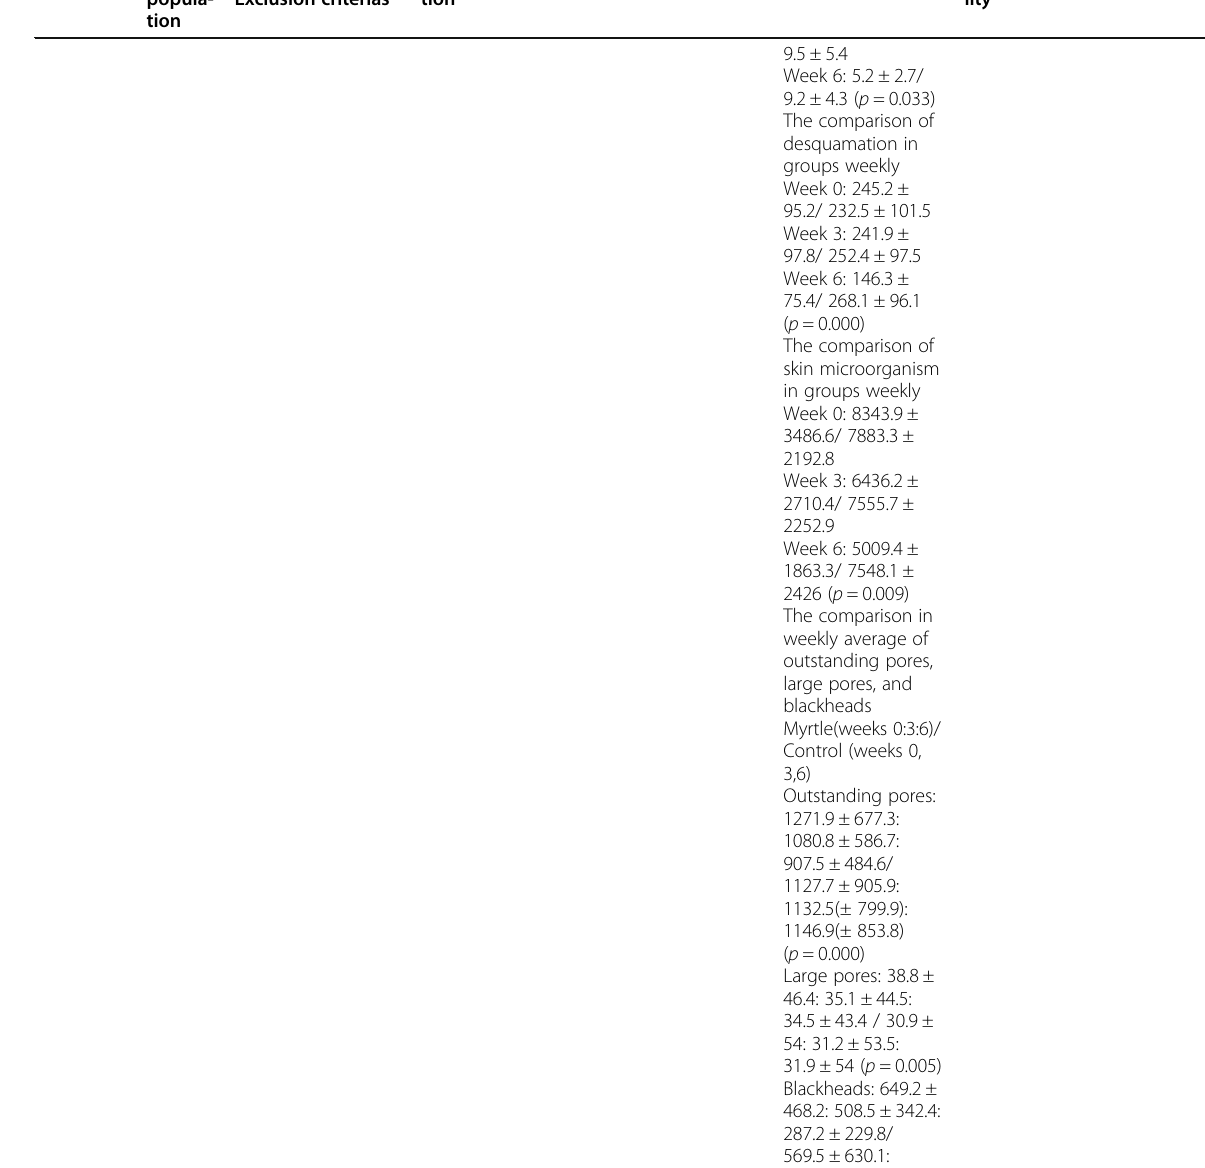
Table 4 Clinical trials of the traditional plants used for skin problems in Turkey (Continued) Study Patient